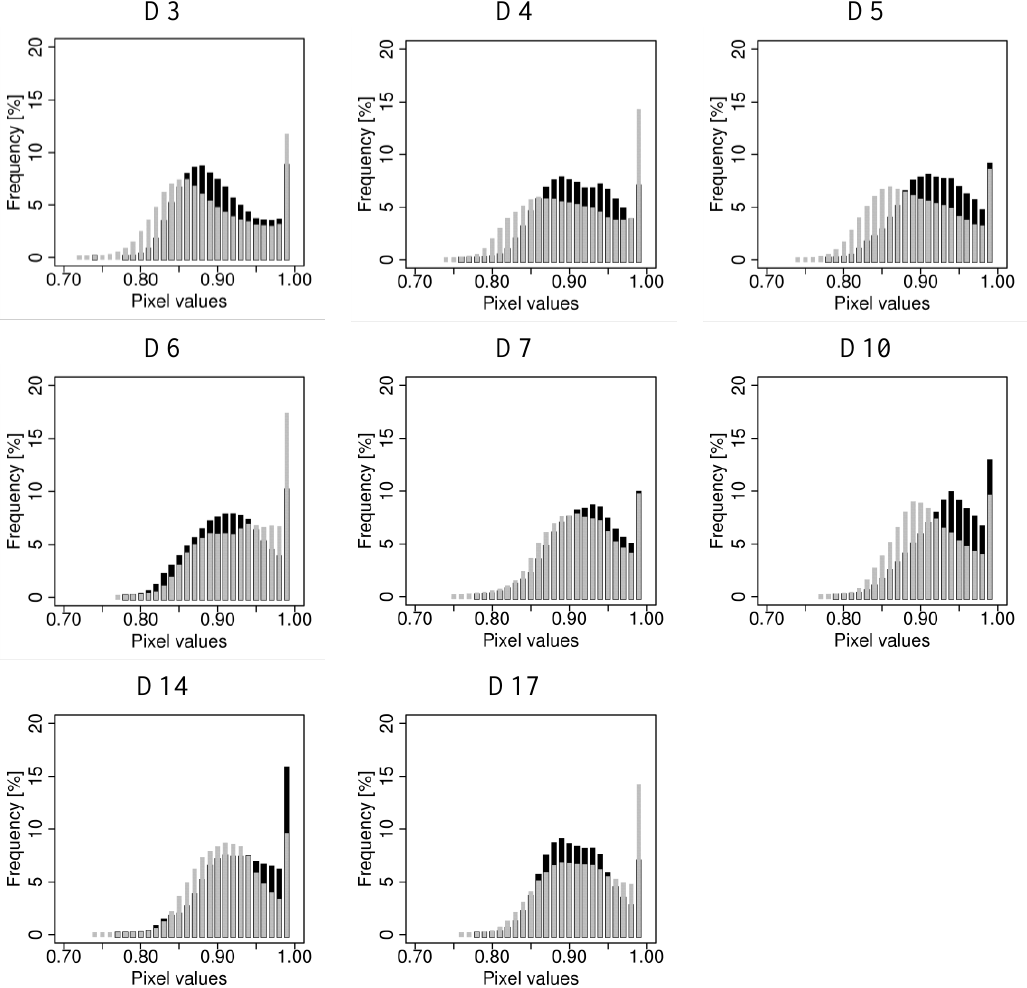
Figure 1. Histograms depicting the distribution of the  for all measured scab inoculated (grey) and control leaves (black). Histograms were constructed for images taken at 3, 4, 5, 6, 7, 10, 14 and 17 days after